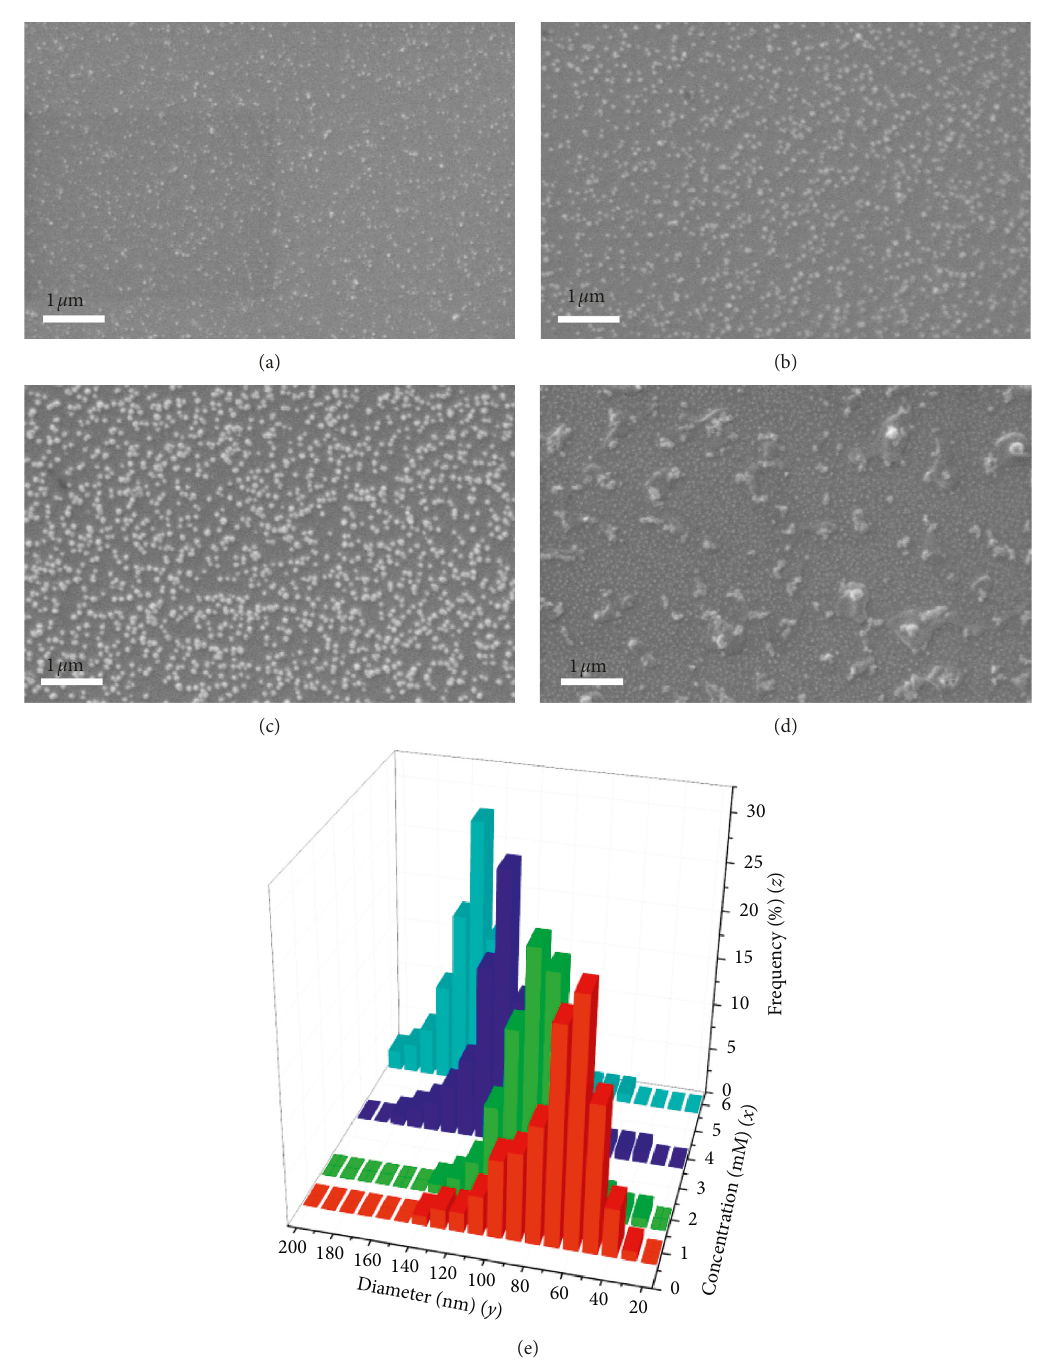
Figure 2: SEM images of PdNPs on the silicon surface obtained by electrolysis in a solution containing 1 mM (a), 2mM (b), 4mM (c), and 6mM (d) of Pd(NO 3 ) 2 , 50mM Bu 4 NClO 4 , and DMSO for 400 cycles at E cathode � − 2.0V and the size distribution histograms of PdNPs